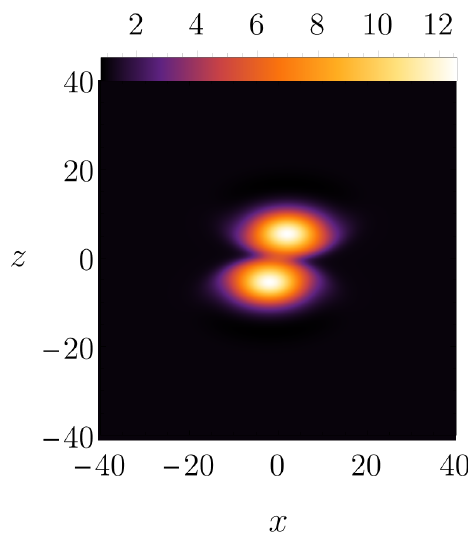
Figure 13 . Mass density at t = 1 . 5 at the collision plane. At this instant the two blobs start to considerably overlap each other and the collision process